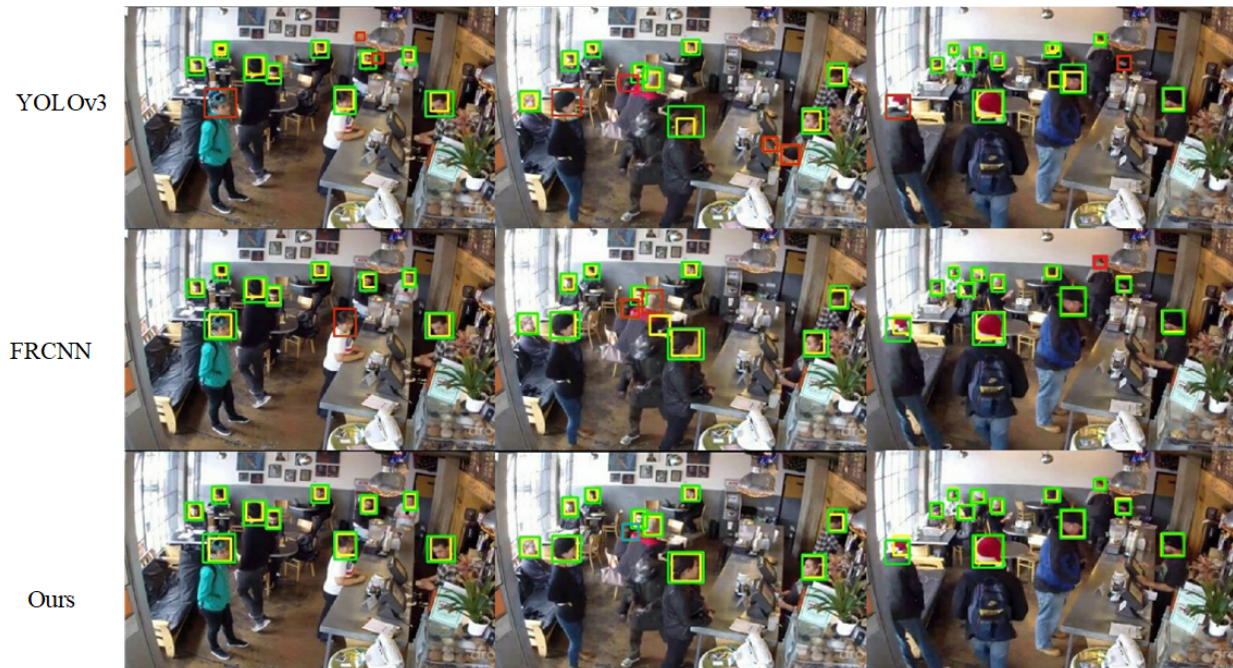
Figure 11. Qualitative results on the Brainwash dataset. The green box is the ground truth, the yellow box is the result of the detection, the red box is the result of missed and false detections, and the blue box is our method used to detect heads that are not labeled in the picture. Different rows show the experimental results of different methods on the Brainwash dataset.